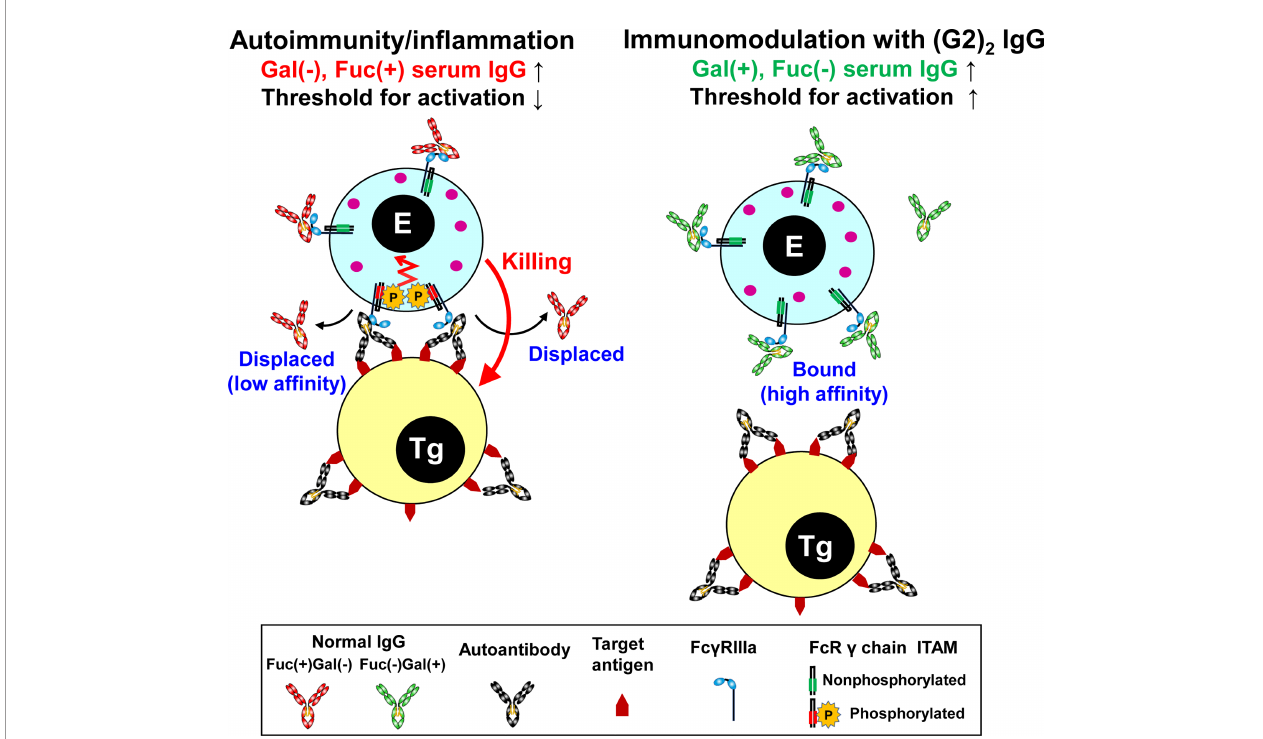
FIGURE 5 | Summary of the mechanism of immunomodulation by the (G2) 2 glycoform of IgG. In autoimmune/in fl ammatory state, hypogalactosylated, fucosylated serum IgG cannot compete with high-avidity multimeric IgG immune complexes on a target cell for Fc g RIIIa binding, resulting in the activation of an effector cell (left). Increased levels of galactosylated, nonfucosylated serum IgG by administration of the (G2) 2 glycoform of IVIG result in saturation of Fc g RIIIa with the (G2) 2 glycoform, inhibiting the activation of an effector cell (right). E, effector cell. Tg, target cell. Gal, galactose. Fuc,